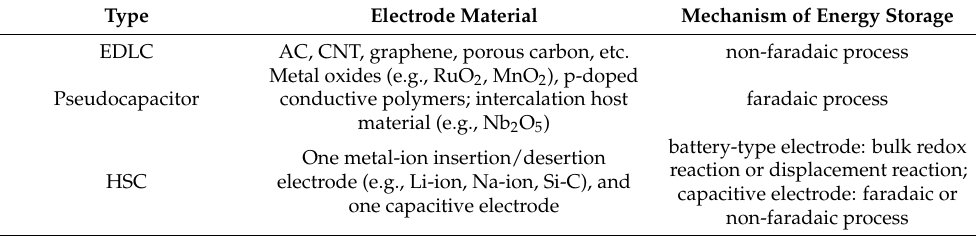
Table 1. Summary of various SC electrode materials and energy storage mechanisms, reproduced with permission from [37]. Copyright 2020, Elsevier.